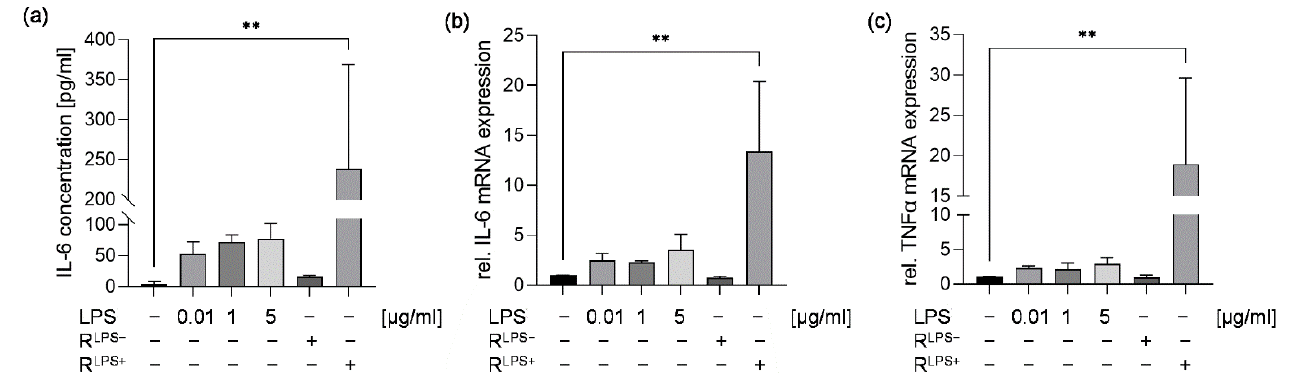
Figure 1. Treatment of cardiomyocytes with conditioned medium of LPS-stimulated macrophages results in an elevated IL-6 concentration and relative IL-6 and TNF α mRNA expression. Cardiomy- ocytes exposed to either 0.01, 1, or 5 µg/mL LPS or conditioned medium of macrophages stimulated in the presence (R LPS+ ) or absence (R LPS − ) of 10 ng/mL LPS for 6 h compared with unstimulated cells were analyzed regarding ( a ) IL-6 protein concentrations utilizing ELISA, ( b ) relative IL-6 and ( c ) TNF α mRNA expression measured by quantitative real-time PCR. Data are presented as a column bar graph as the mean ± SD (all n = 3). One-way ANOVA followed by Tukey’s test was used for multiple comparisons. ** p < 0.01; LPS = lipopolysaccharide; IL-6 = interleukin-6; TNF α = tumor ne- crosis factor alpha.